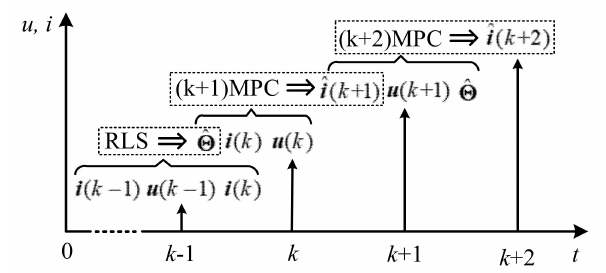
Figure 6. Time sequence of RLS parameter identification and MPC.